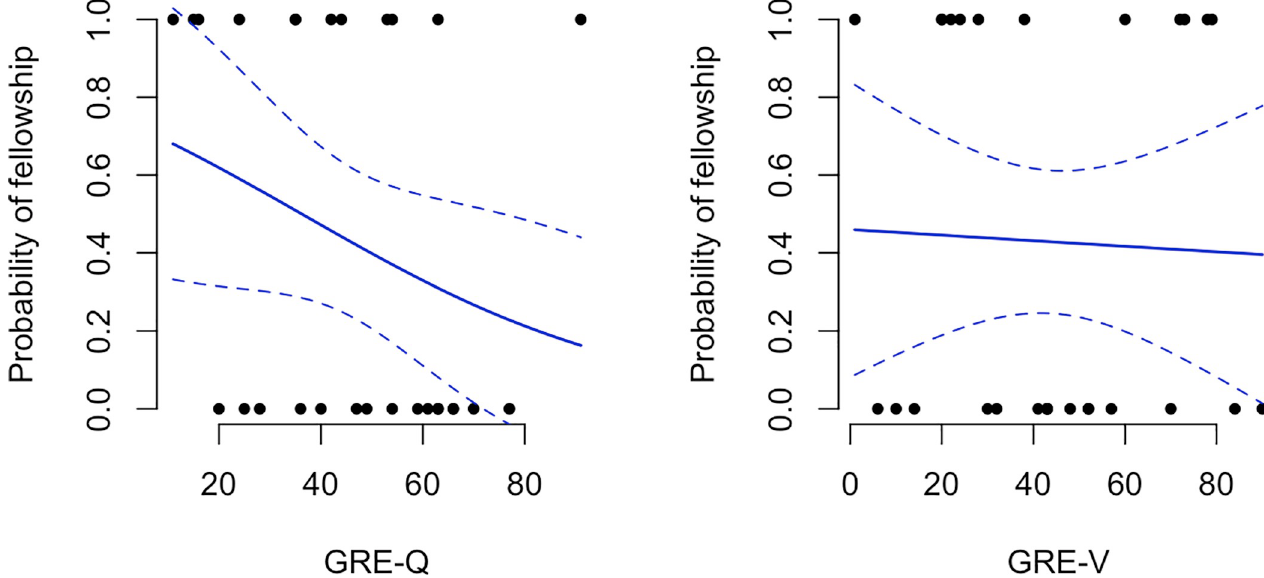
Fig 7. Predicted probability of obtaining a fellowship as a function of GRE scores. Data are for fellowships listed in Table 3. The raw data points are overlaid (0 = No fellowship, 1 = Fellowship).